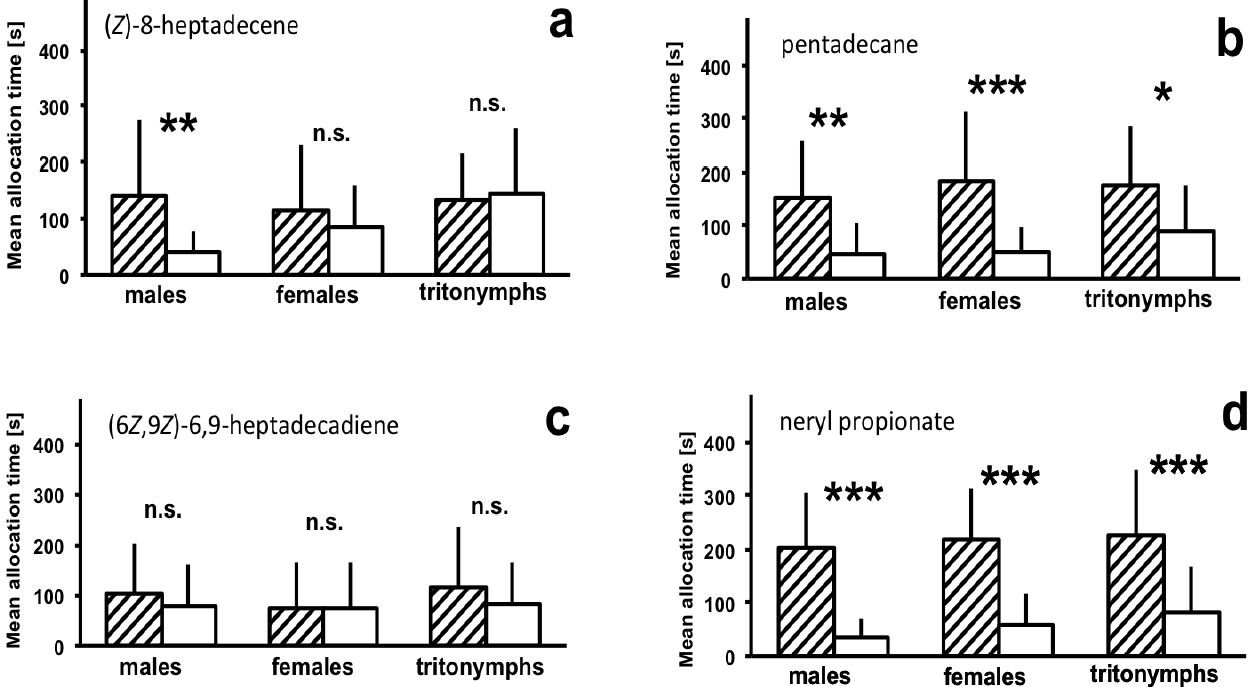
Figure 4. Reaction of males, females and tritonymphs of D. pteronyssinus to synthetic odors. The graph presents the mean allocation time (+S.D., n = 25) in the odor field of a two-chamber olfactometer above chambers with a filter paper containing a synthetic odor dissolved in hexane (hatched bars) or control chambers containing a filter paper with the respective amount of hexane (white bars). n.s.—no significant difference between test and control field; * p < 0.05; ** p < 0.01; *** p < 0.01 (Wilcoxon-matched pairs test) ( a ) 30 ng ( Z )-8-heptadecene (30  L of 1 ng/  L) ( b ) 30 ng pentadecane (30  L of 1 ng/  L) ( c ) 2  g (6 Z ,9 Z )-6,9-heptadecadiene (20  L of 0.1  g/  L) ( d ) 0.1 ng neryl propionate (10  L of 0.01 ng/ 